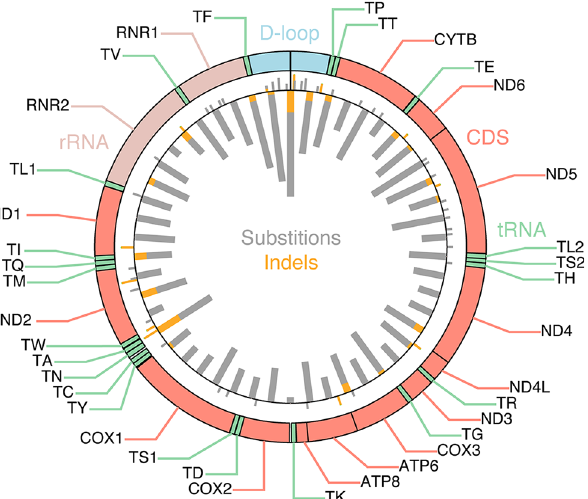
Fig 1. Mutational density across the mitochondrial genome. Inward-facing thick bars indicate the number of mutations per 331 nt segment (50 segments), with substitutions and indels shown in gray and orange, respectively. 616 somatic mutations, identified across 527 tumors, are shown. Outward-facing bars thin bars indicate individual recurrently mutated positions ( > = 2 tumors).